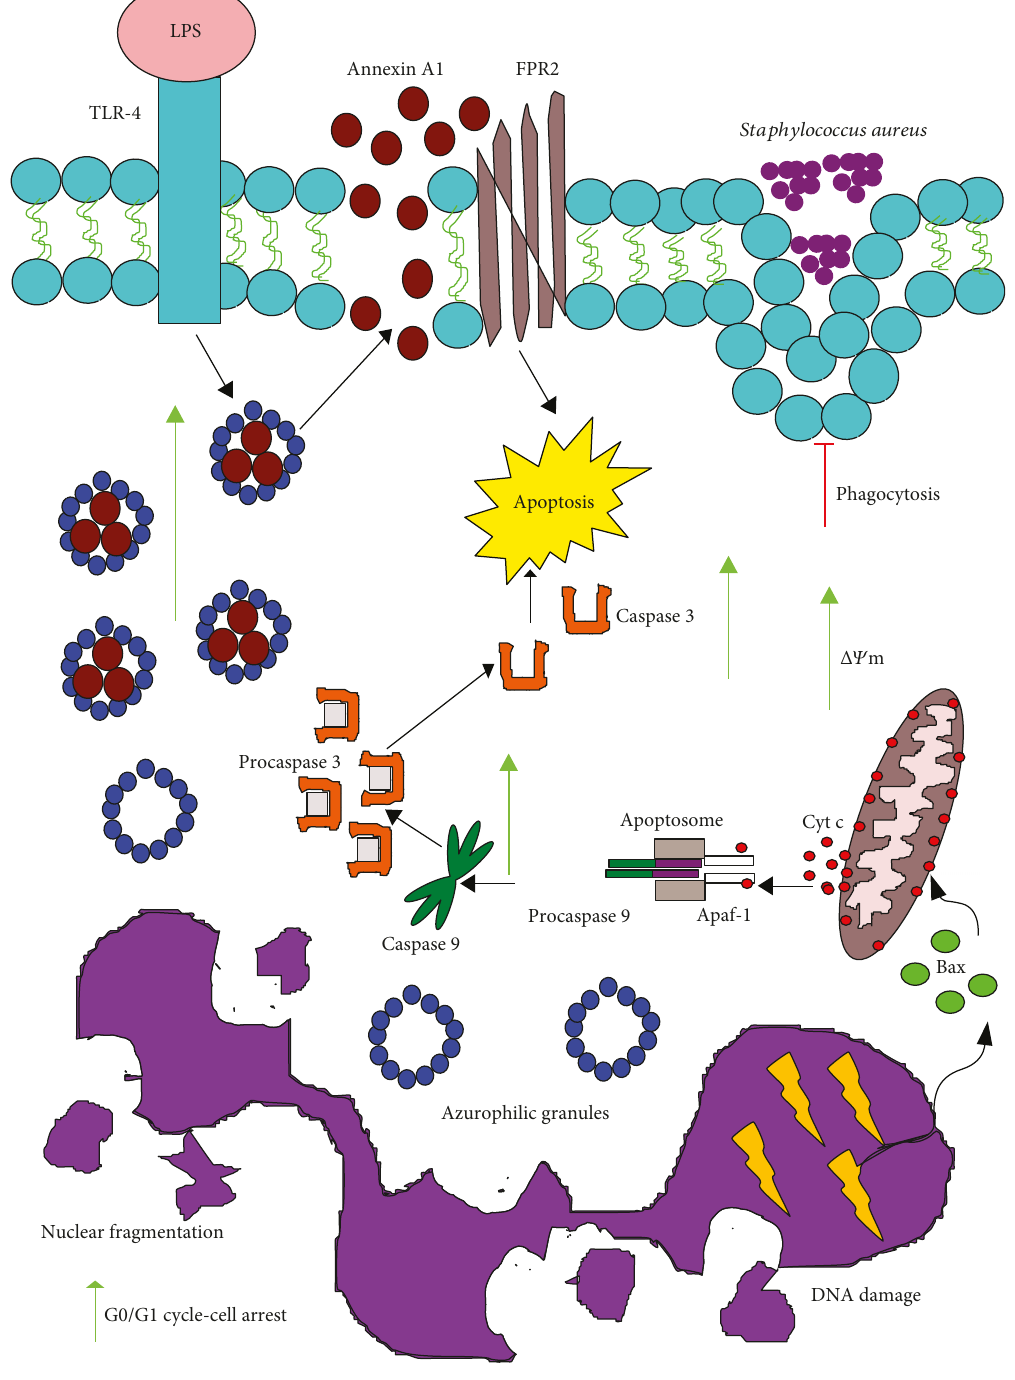
Figure 6: VPA induces apoptosis in neutrophils and diminishes their phagocytic capacity. VPA induces apoptosis in neutrophils in response to LPS, by increasing annexin A1 release. Additionally, VPA on its own can alter the mitochondrial membrane potential and increase activation of the both caspase 9 and caspase 3, which activate the apoptosis intrinsic pathway. Furthermore, VPA impedes proliferation by stopping the cells in the G0/G1 cell cycle phase. Finally, VPA reduces their phagocytic and antimicrobial activities against Staphylococcus aureus . Green arrows indicate the processes, molecules, or mediators in the signaling pathway that are augmented and/or promoted by VPA. Red arrows indicate processes, molecules, or mediators in the signaling pathway that are inhibited by